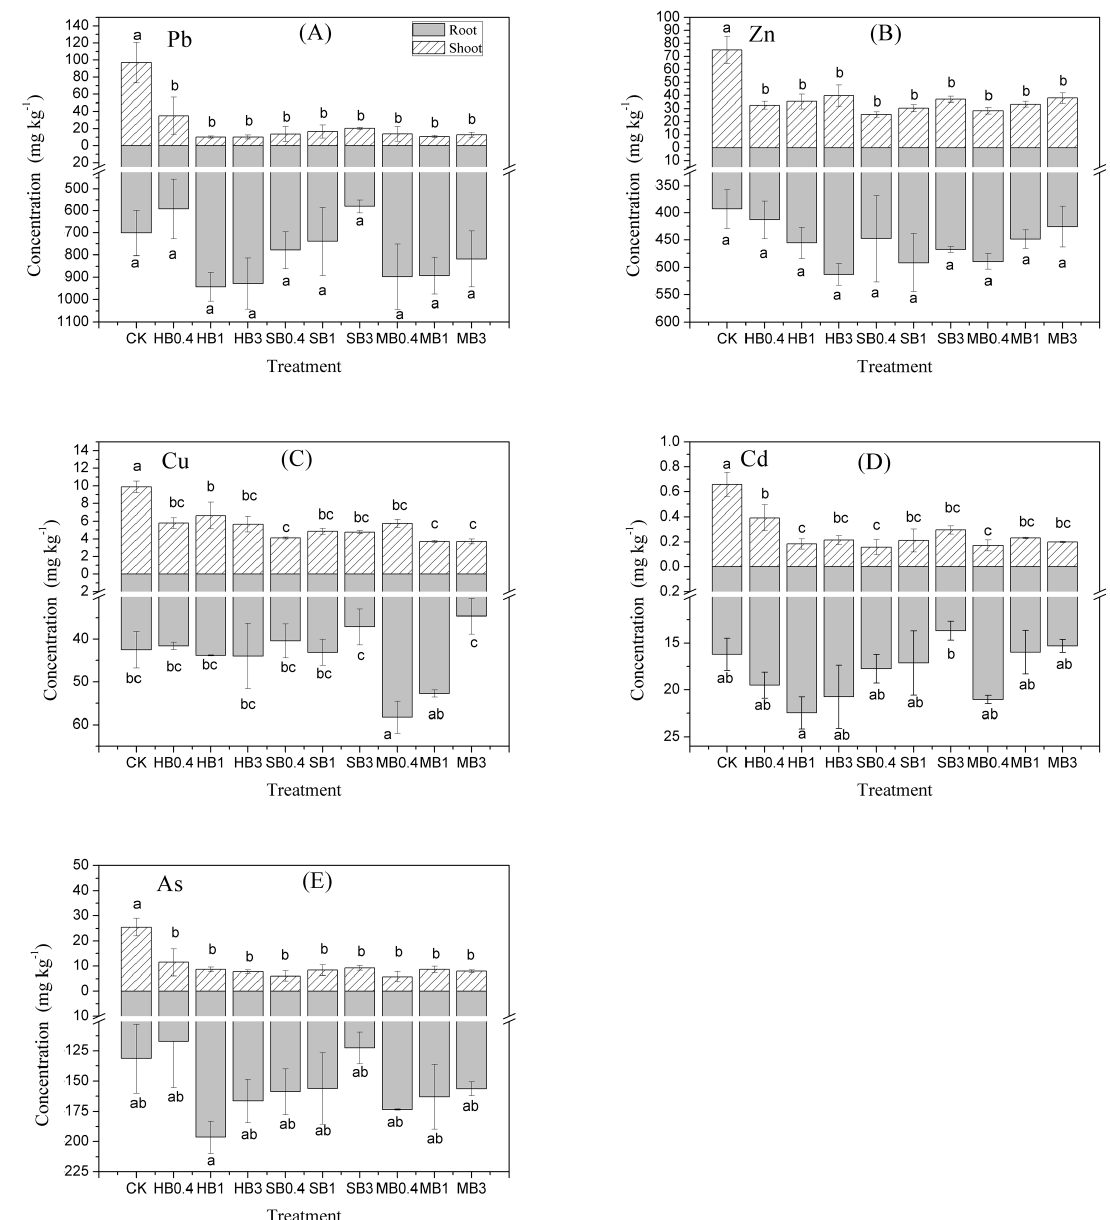
Figure 2. Effects of HB, SB and MB treatments on ( A ) Pb, ( B ) Zn, ( C ) Cu, ( D ) Cd and ( E ) As contents in shoots and roots of Cassia alata L. The vertical bars in the figures represent the standard errors of the means ( n = 3), Different letters indicate significant differences among different treatments at a significance level of 0.05. CK, HB/SB/MB0.4, HB/SB/MB1 and HB/SB/MB3 refer to no biochar input and the incorporation of biochar into the soil at 0.4%, 1% and 3% by mass, respectively. HB: Hibiscus cannabinus core biochar; SB: sewage sludge biochar; MB: chicken manure biochar.